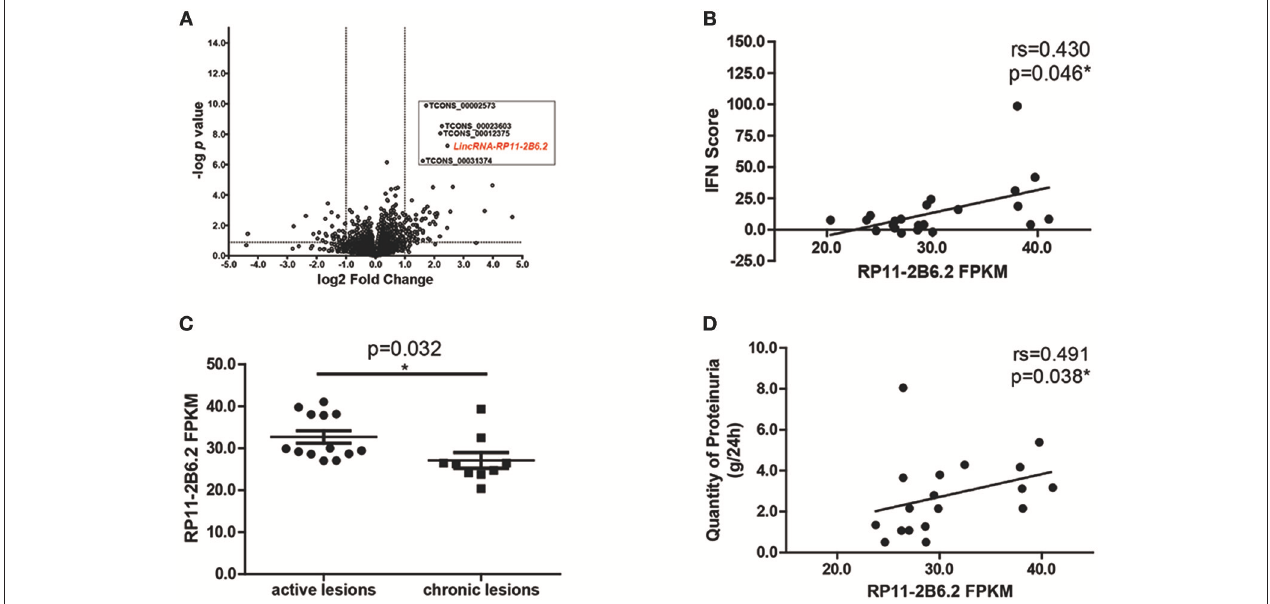
FIGURE 1 | LncRNA RP11-2B6.2 Expression Is Increased in LN Patients. (A) 78 lncRNAs showed differential expression in transcriptome profiling of renal tissues from 22 LN patients compared to 7 controls. The vertical lines correspond to a 2-fold upregulation or downregulation, and the horizontal line represents P = 0.05. (B) Positive correlation between lncRNA RP11-2B6.2 levels and IFN scores in kidney biopsies of LN patients. (C) Patients were classified using the LN Activity/Chronicity Index, and the expression of lncRNA RP11-2B6.2 in LN patients with different disease activity was presented. (D) Positive correlation between lncRNA RP11-2B6.2 levels and concurrent quantity of 24-h proteinuria from LN patients. The figure (B–D) showed the number of fragments per kilobase of exon per million fragments mapped (FPKM). Non-parametric Mann–Whitney U -test was used in (C) . Spearman’s test was used in (B,D) . * P < 0.05.